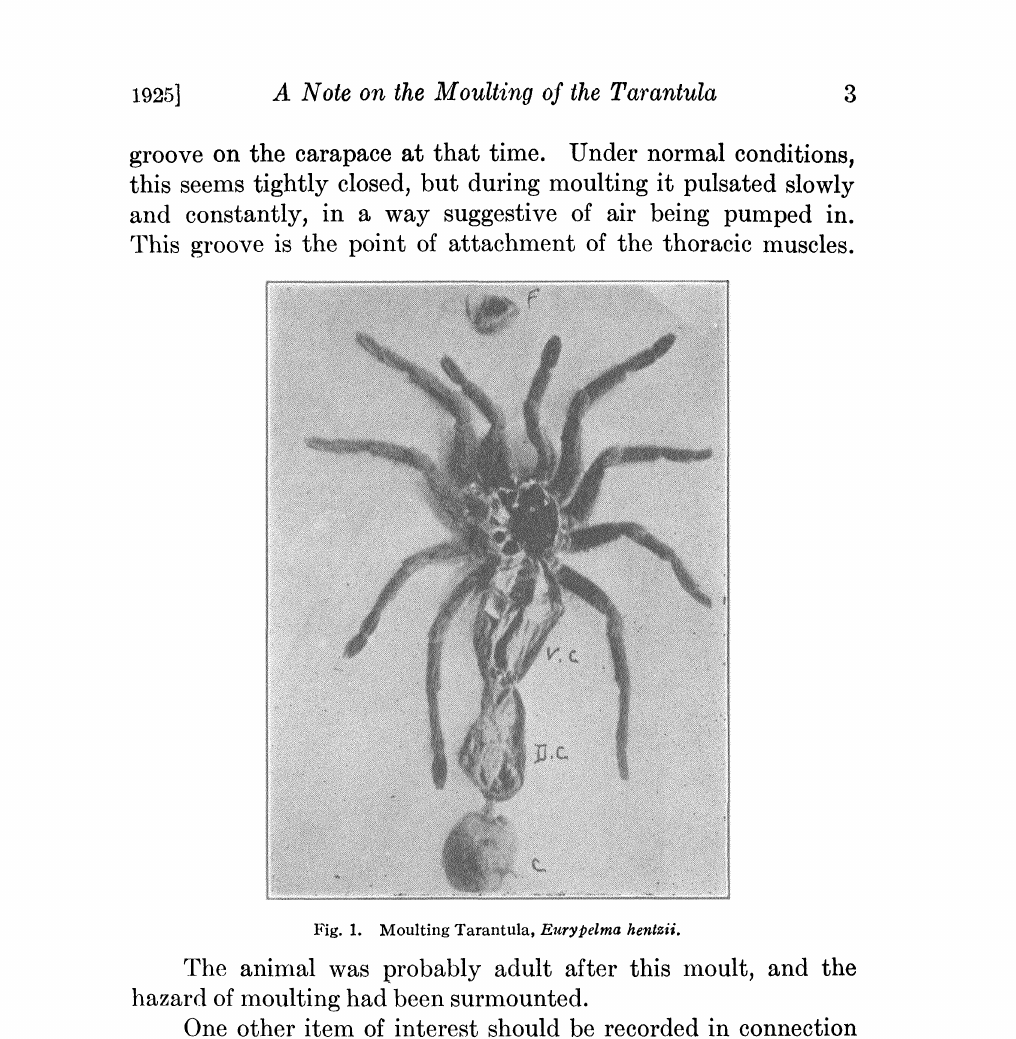
Fig. 1. Moulting Tarantula, Eurypelma